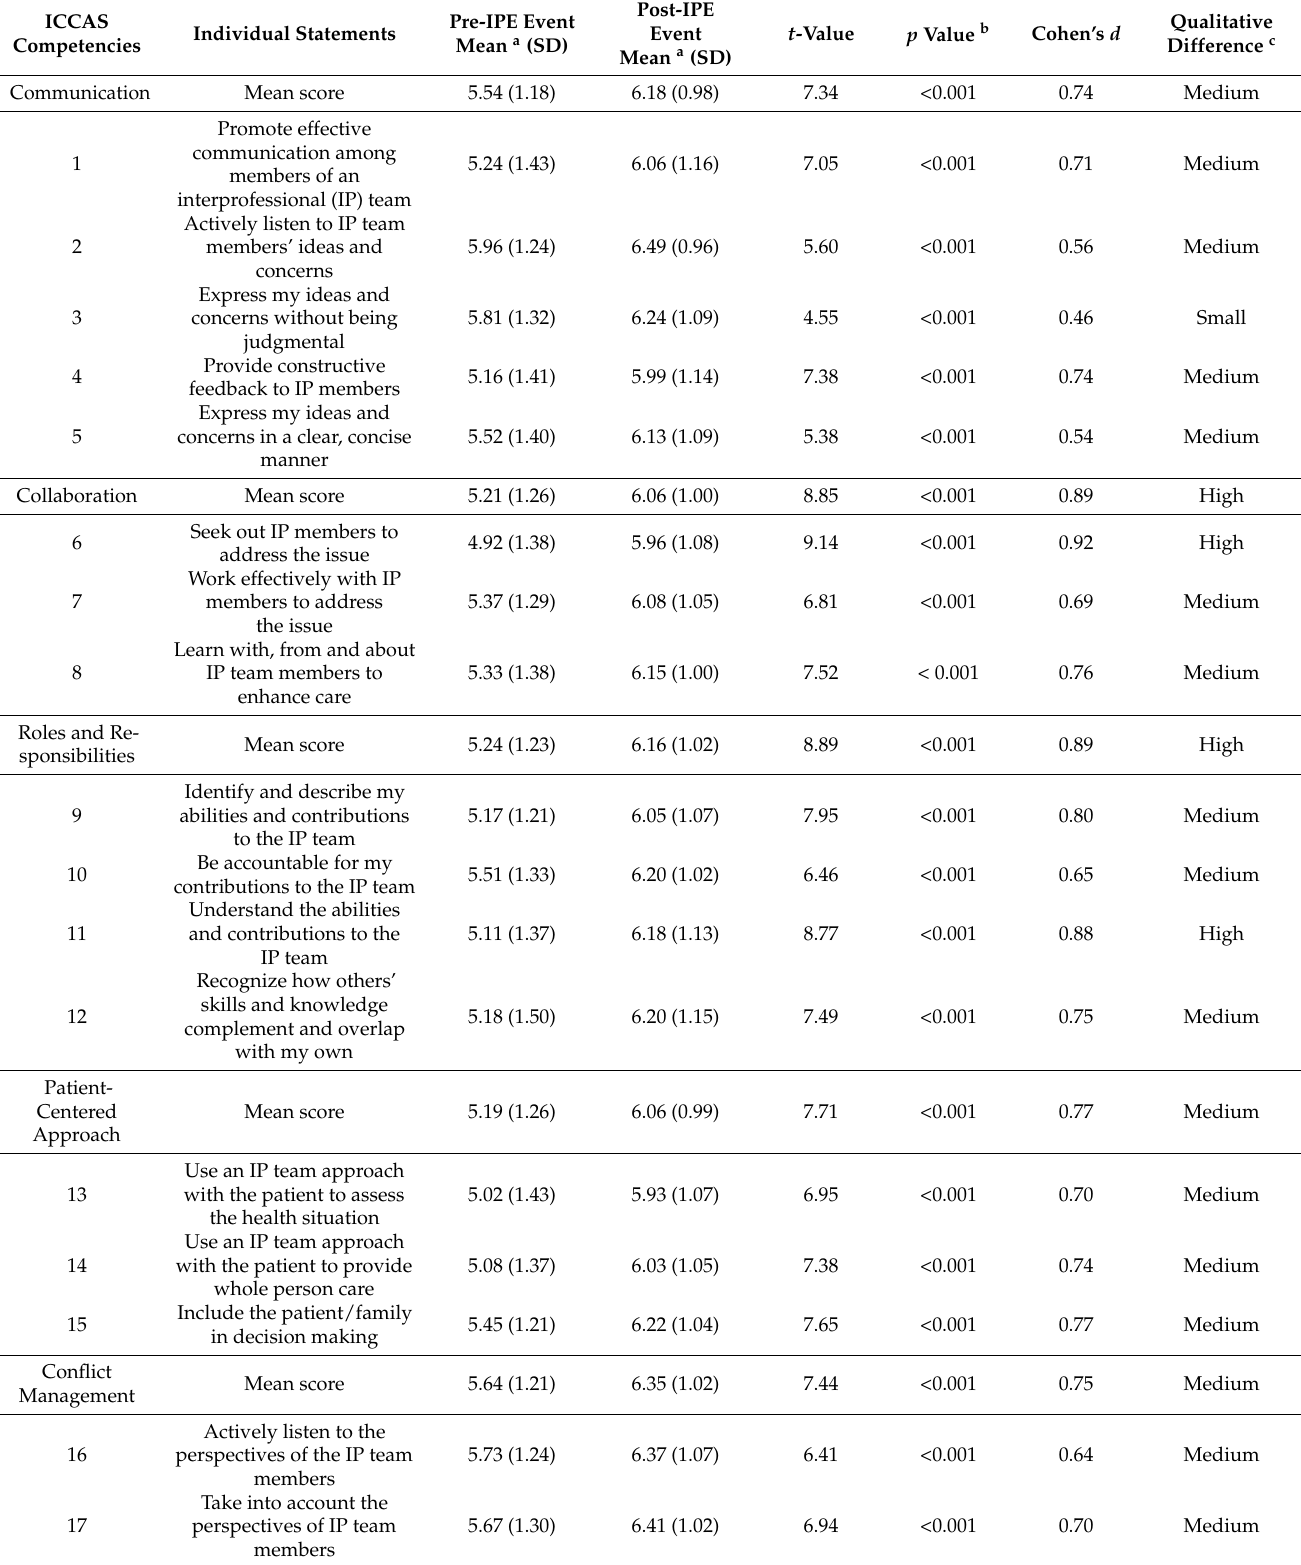
Table 1. Self-Perceived Interprofessional Collaborative Competency Attainment Survey (ICCAS) of First-Year Healthcare Students Before and After Participating in an Interprofessional Education Event (N =